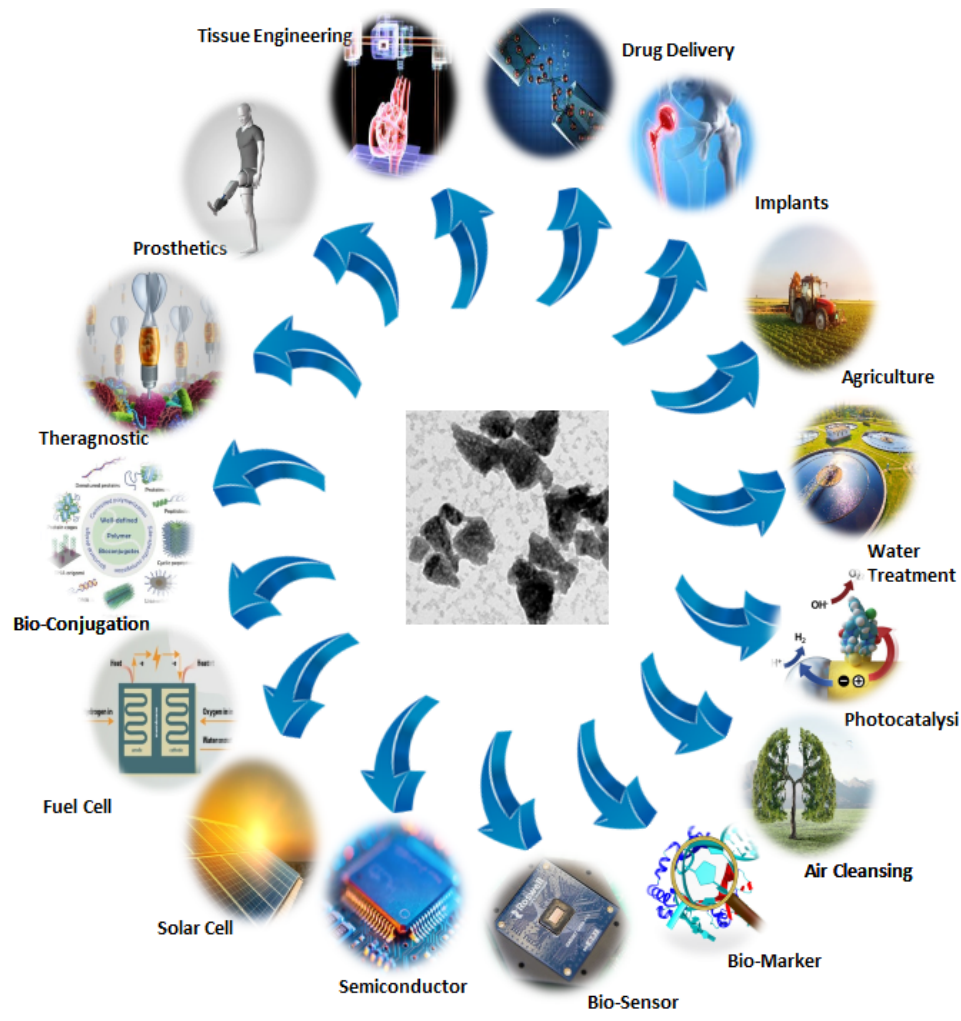
Figure 1. Applications of N-ZnO Ps.